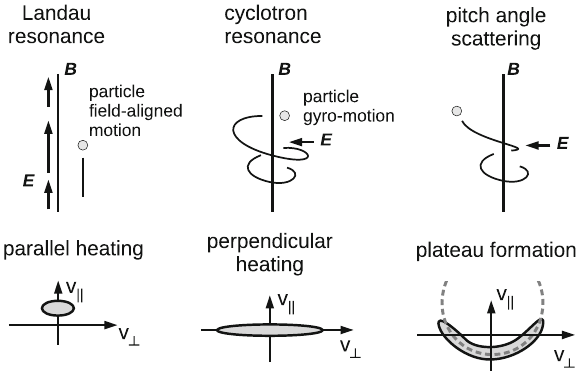
Fig. 5 Sketches of wave–particle interactions in a plasma and the associated population in the velocity distribution function. Image reproduced with permission from Narita (2017b), copyright by the